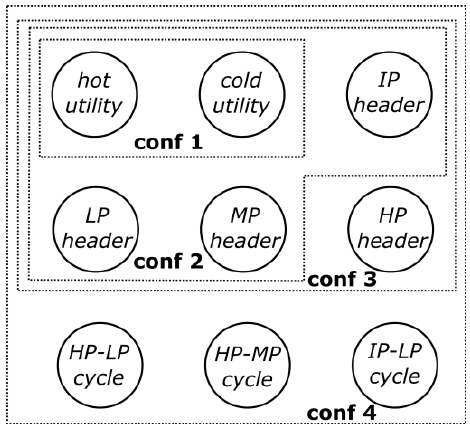
Figure 7. Overview of the units defined for the various utility system configurations.